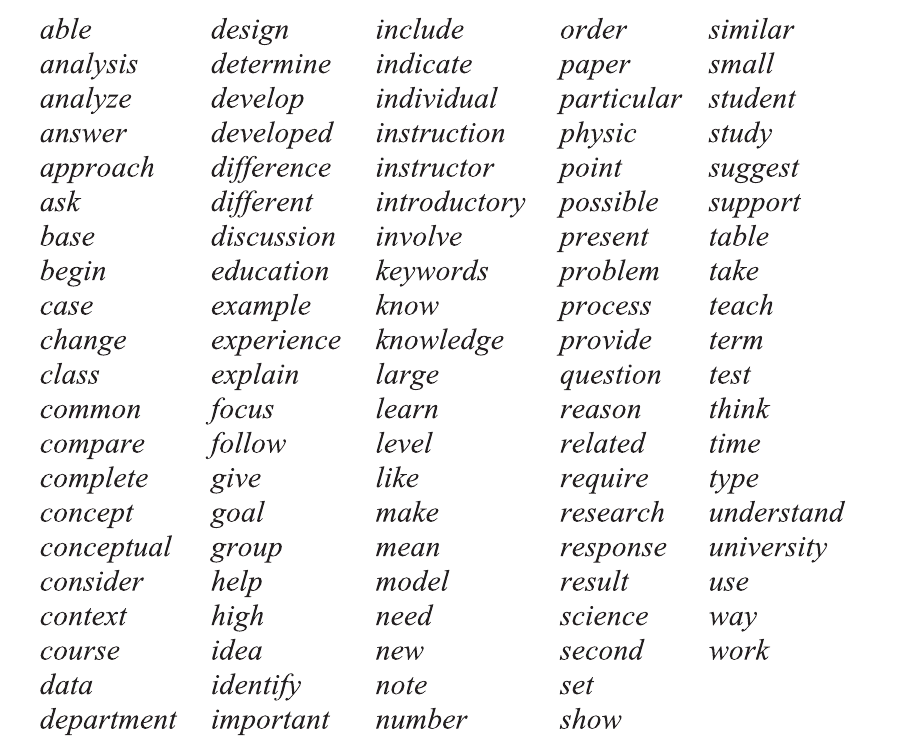
FIG. 5. Alphabetical list of most frequent words in data corpus, removed using frequency filter of